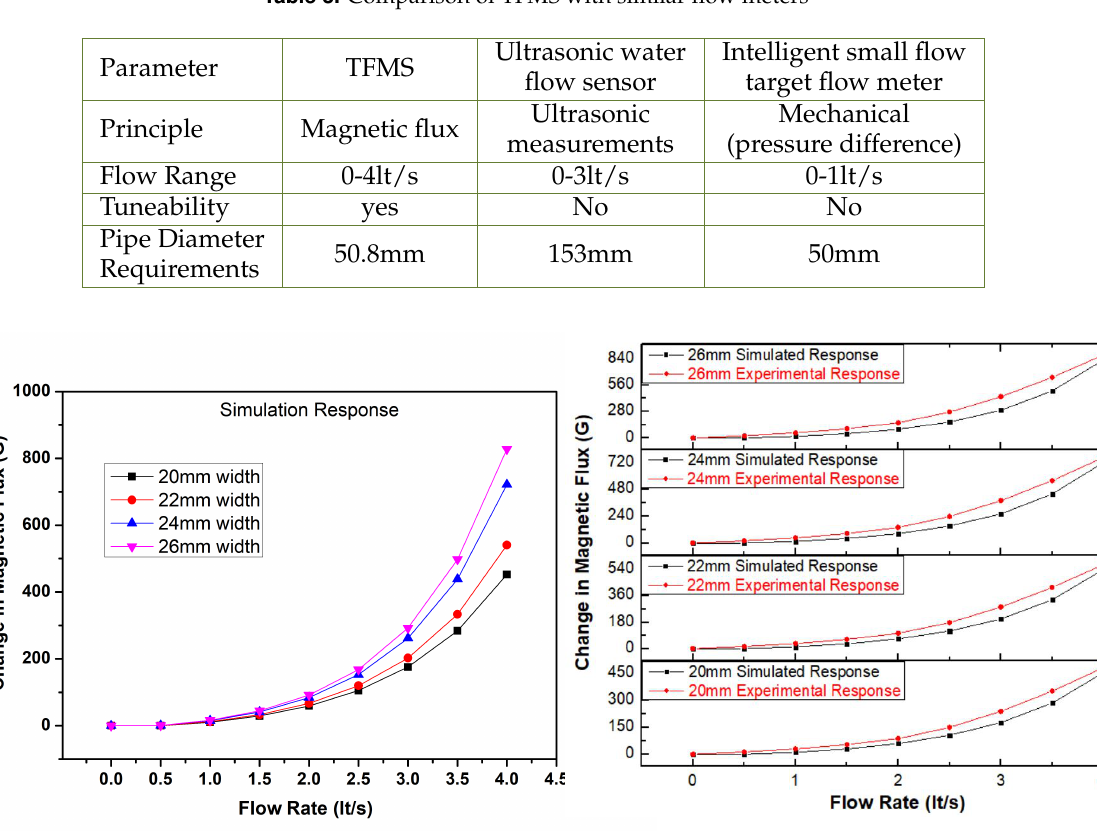
Fig. 10. Comparison of FMS response against commercial flow meter